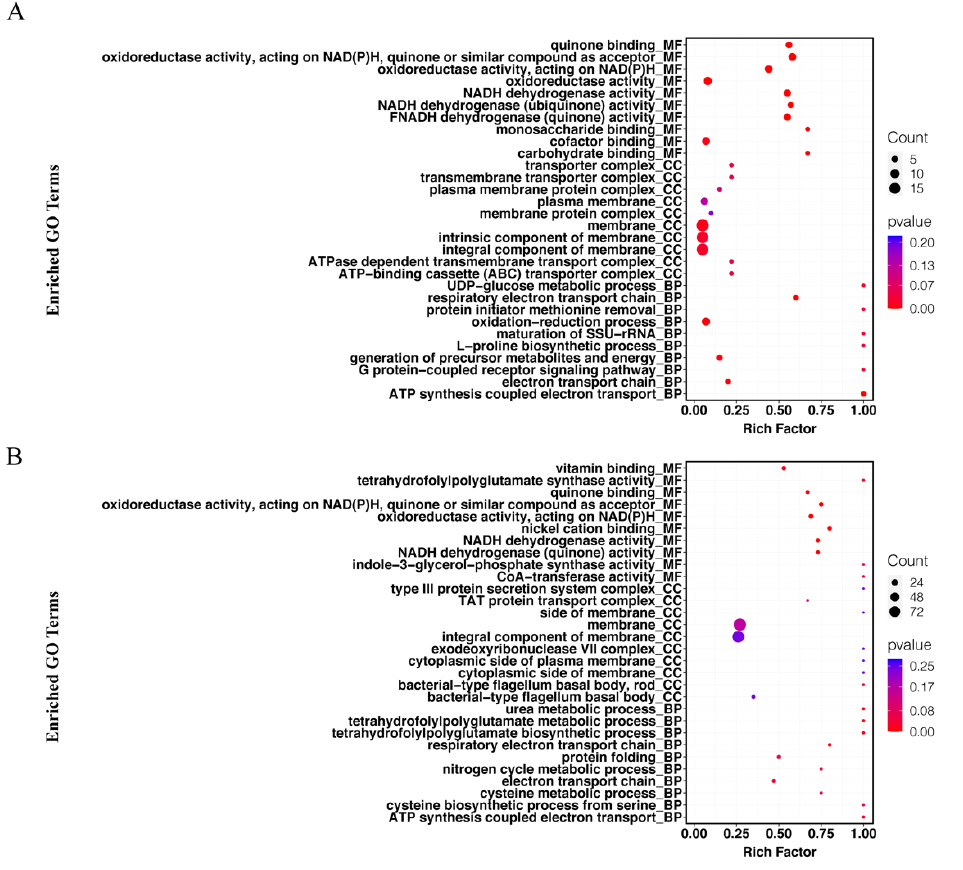
Figure 7. ClueGO analysis for GO terms ( p < 0.1) in H. pylori 3192 biofilm under different treatments. Each node in the graph represents a GO term, the connection between nodes reflects the correlation between terms, and the color of the nodes reflects the enrichment and classification of the node.